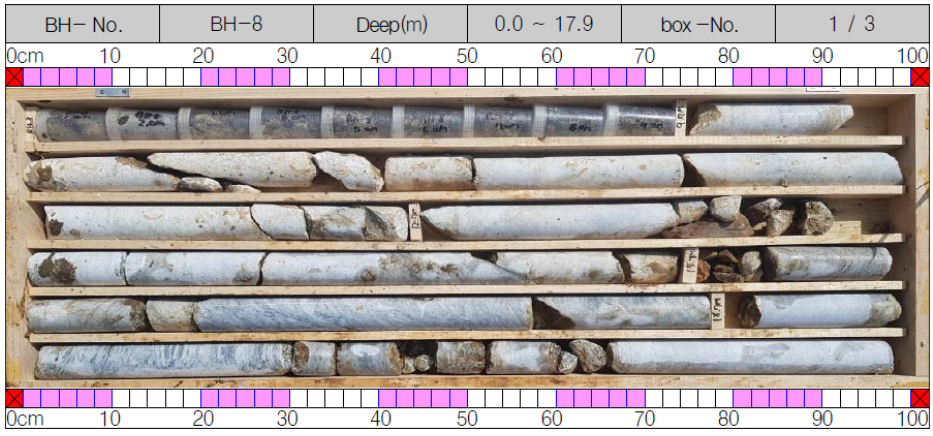
Figure 16. A core box from the present research.